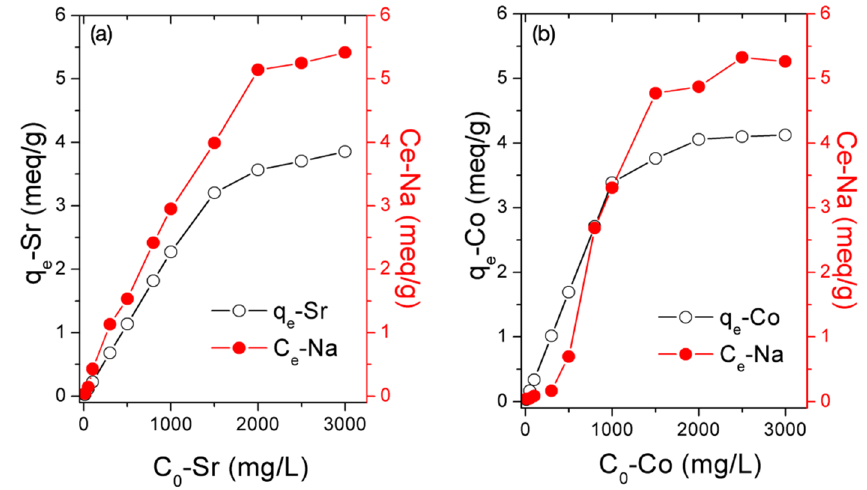
Figure 6. Adsorption − desorption of ( a ) Sr-Na and ( b ) Co-Na at various